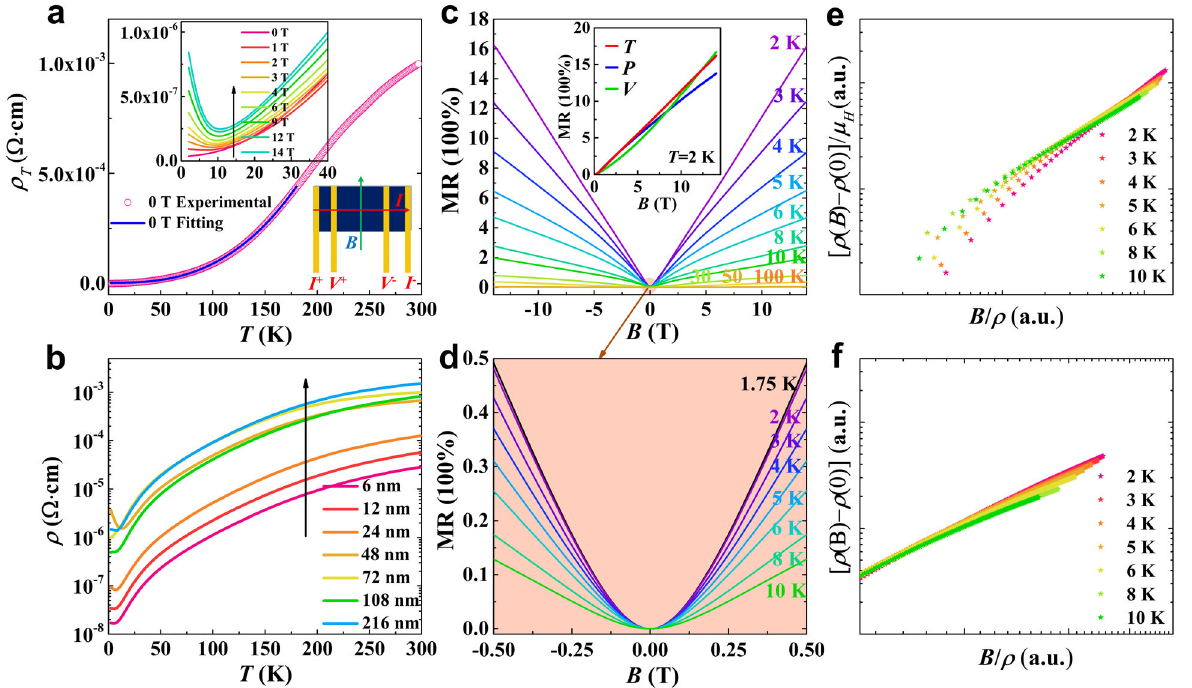
Fig. 2 Transport properties of SCMO thin fi lms. a Temperature-dependent resistivity curve of S 5 sample from 2 to 300 K in the absence of a magnetic fi eld. Inset: the RT curves from 2 to 40 K at various magnetic fi elds up to 14 T. b The zero- fi eld RT curves from 2 to 300 K of SCMO thin – S fi lms: S 1 7 . c The MR curves of S 5 sample at various temperatures from 2 to 100 K, the low- d . Inset: the MR curve in different con fi gurations at 2 K. e , f The Kohler ’ s plots of MR curves in panel c , d , respectively, in which the scaling rules are slightly